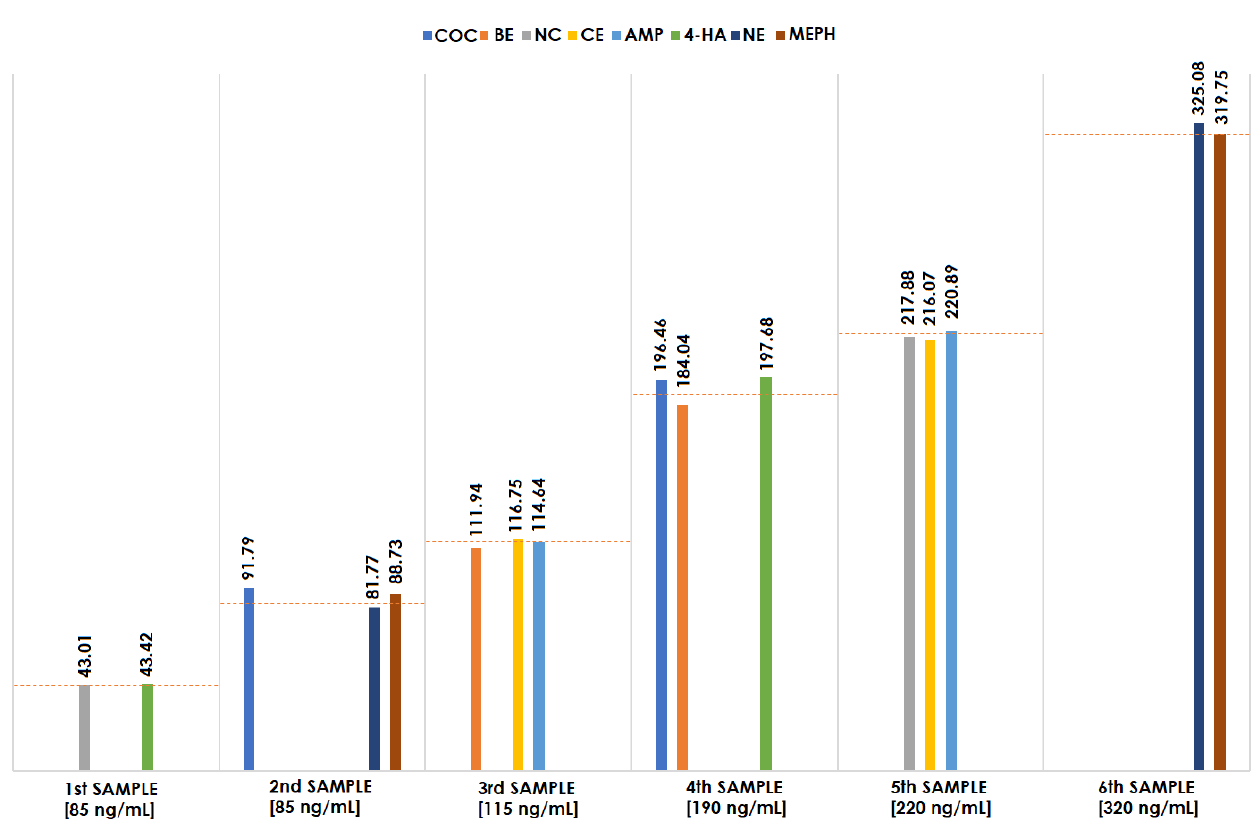
Figure 2. Results of the intra-laboratory test for blood samples and their comparison between the obtained and expected concentrations of the tested narcotics.